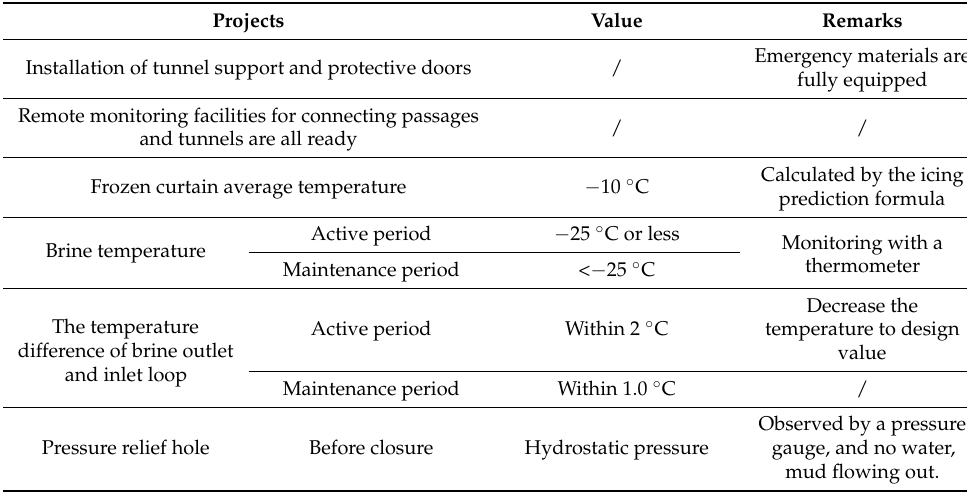
Table 3. Technical indices in the excavation of